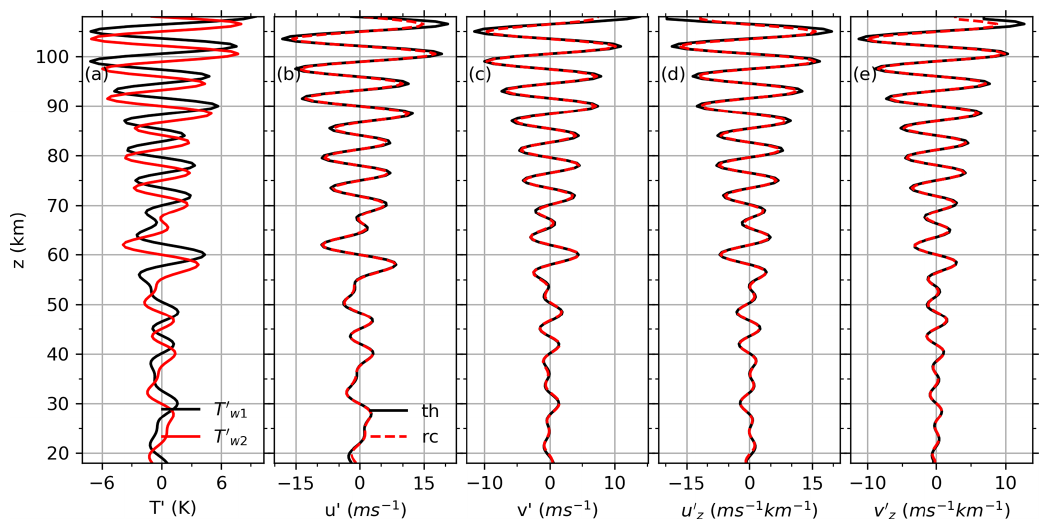
(z) and T (cid:48) (z) are represented by black and red lines, respectively) and the Figure 1. Synthetic temperature perturbation profiles ( a , T (cid:48) w1 w2 corresponding winds ( b , zonal; c , meridional) and shears ( d , zonal; e , meridional). The winds and shears are, respectively, calculated from the prescribed amplitudes and wavenumbers (black line, labeled as “th”) and reconstructed by spectral decomposition method (red dashed line, labeled as “rc”). All panels have the same y -axis